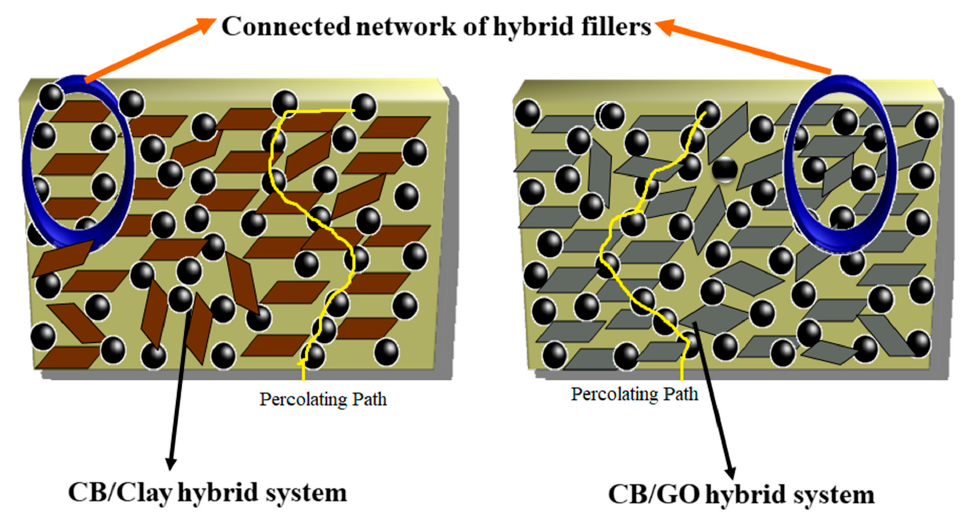
Figure 7. Schematic representation showing the interaction of GO and nanoclay with carbon black (CB) and the difference in dispersion of both the fillers in presence of CB.